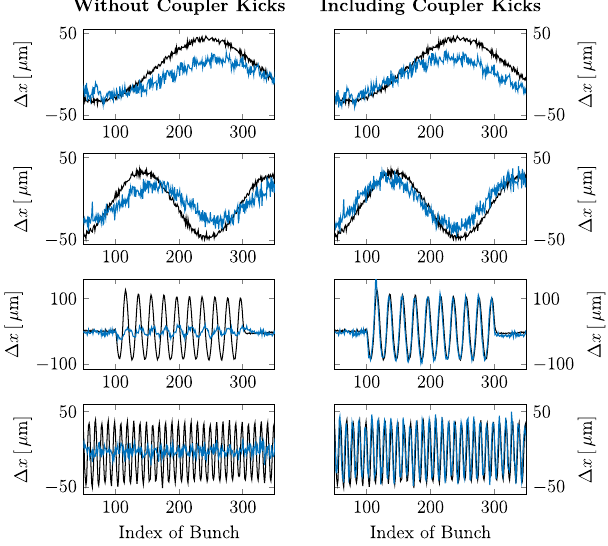
FIG. 8. Difference between the reference trajectory and the trajectory while applying modulations with different frequencies on the klystron power (from top to bottom: 3 kHz, 5 kHz, 50 kHz and 100 kHz). The BPM readout differences (black) and the corresponding model evaluations (blue) are plotted for the horizontal plane downstream the injector module at FLASH. The beam transport calculations are done both, excluding (left) and including (right) coupler kicks. At high modulation frequen- cies the transverse dynamic is dominated by the variation of coupler